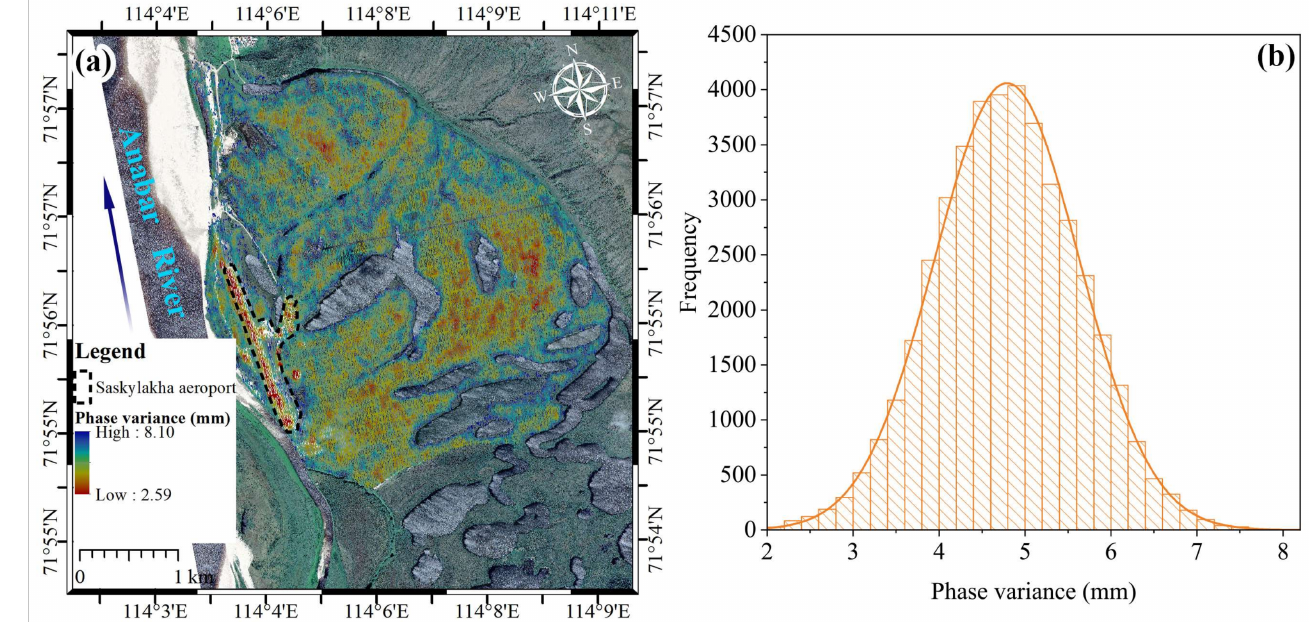
Figure 3. Phase variance distribution and histogram in Saskylakh, northwestern Yakutia, Siberian Arctic, Russia. Notes: ( a ) map of the spatial distribution of phase variance in SBAS-InSAR accuracy; and ( b ) histogram of phase variance in Saskylakh, in which the percentages in the figure are the proportion of all results accounted for by different phase variances.